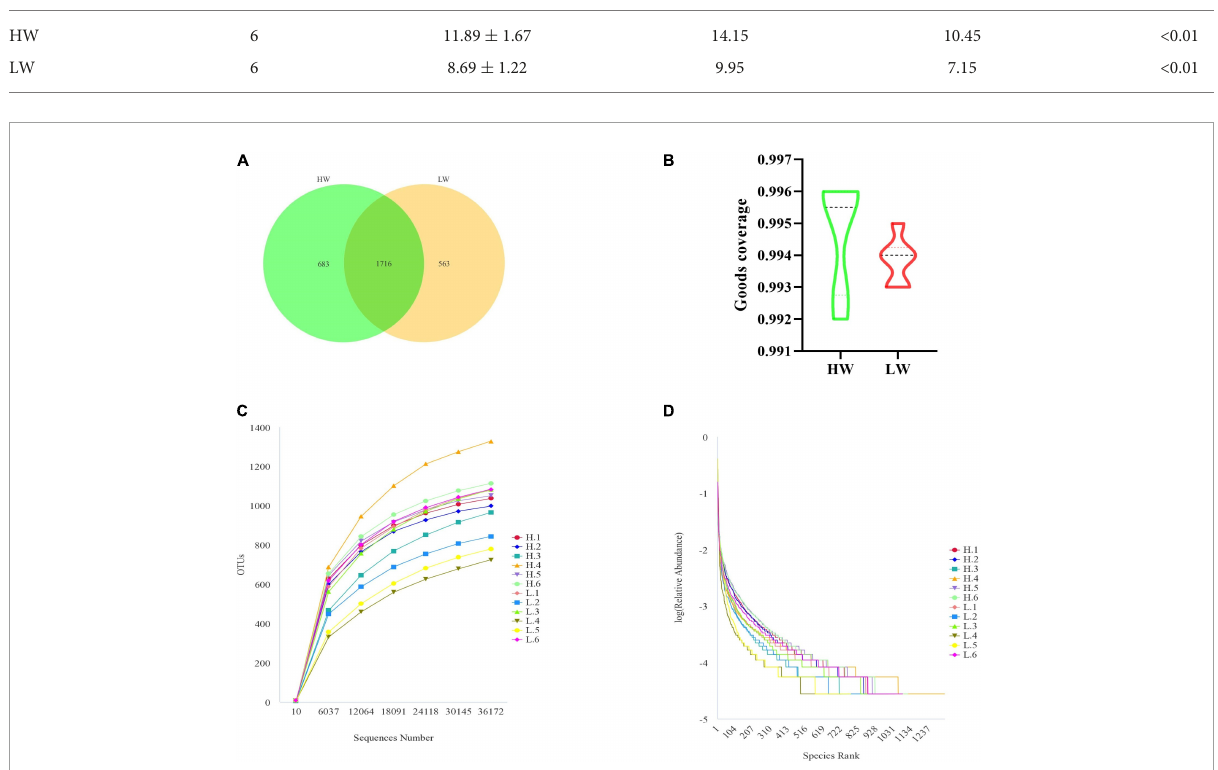
FIGURE1 DNA sequence data analysis. (A) Venn diagram. The numbers in the figure show the unique or shared OTUs of each group. (B) It shows the sequencing depth of the HW and LW groups. Rarefaction (C) and rank-abundance curve (D) analysis of the different fecal samples at 97% sequences identity.